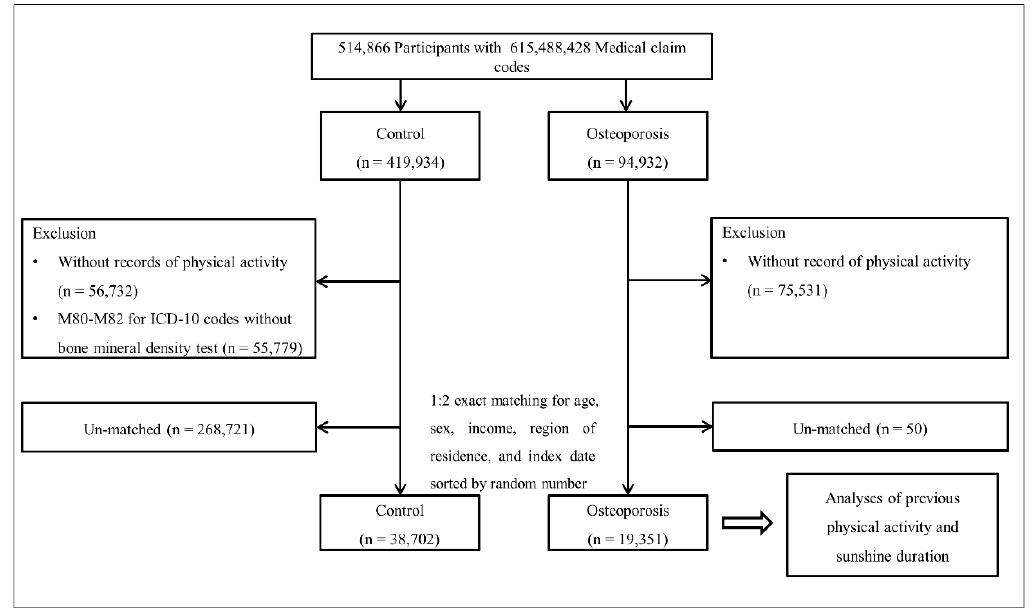
Figure 1. A schematic illustration of the participant selection process that was used in the present study. Of a total of 514,866 participants, 19,351 osteoporosis patients were matched with 38,702 control participants for age, sex, income, and region of residence.